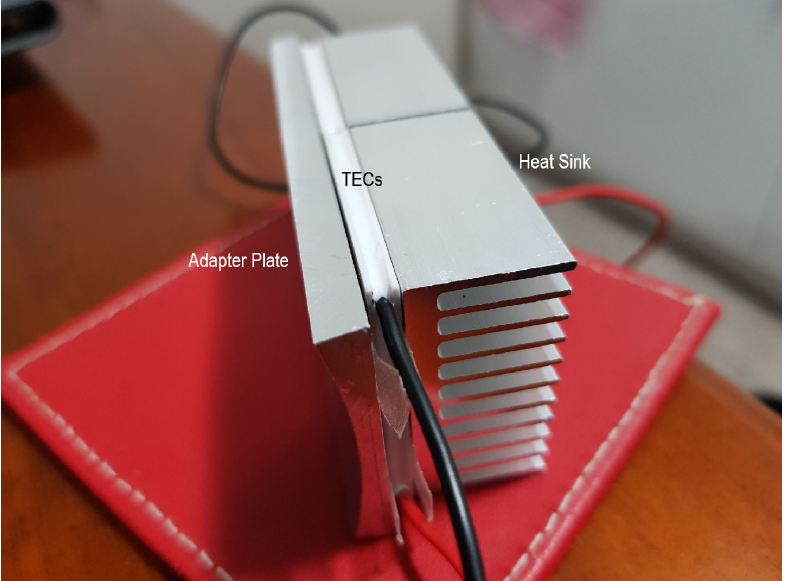
Figure 10. An adapter plate with the TEC and heat sink